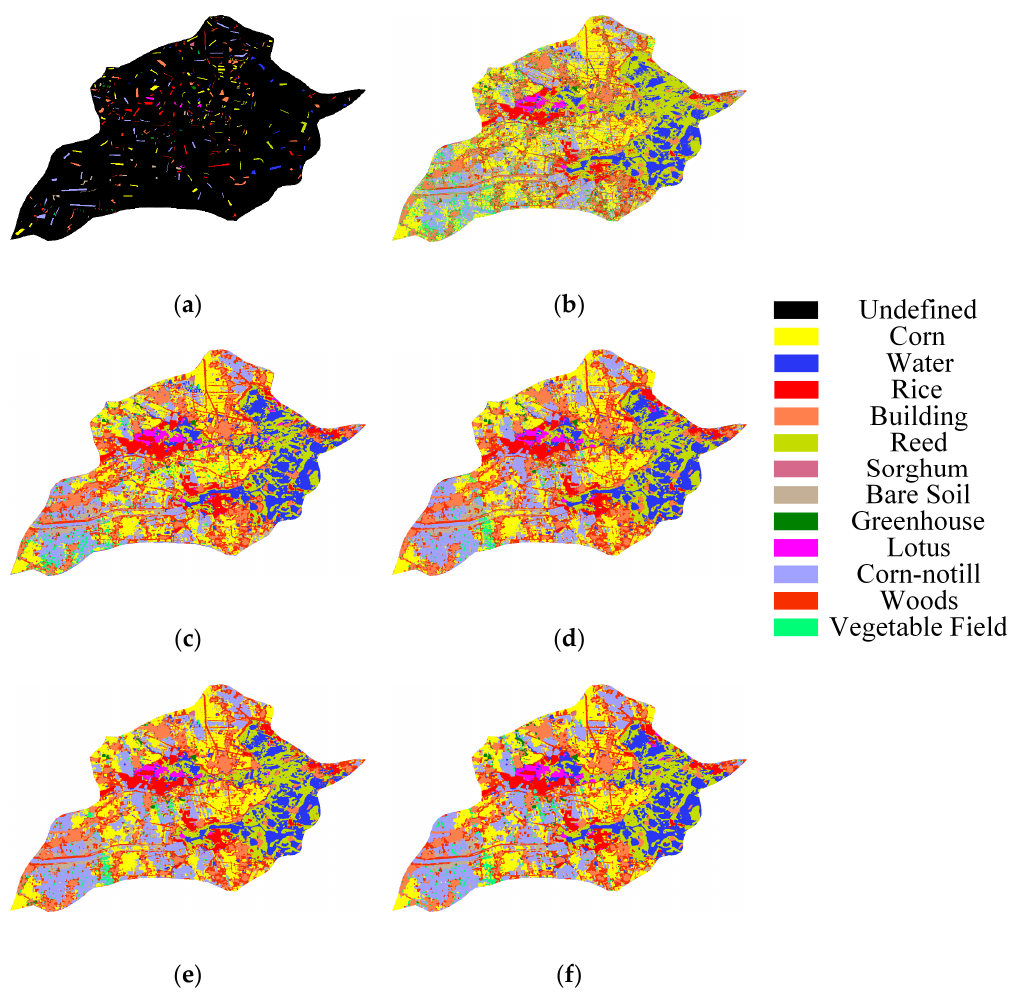
Figure 14. Classification maps for GF5AX dataset: ( a ) Ground-truth map, ( b ) SSLSTMs, OA = 87.47%, ( c ) 3D CNN, OA = 96.75%, ( d ) FDSSC, OA = 98.46%, ( e ) SSRN, OA = 99.32%, ( f ) SSCC, OA = 99.37%.